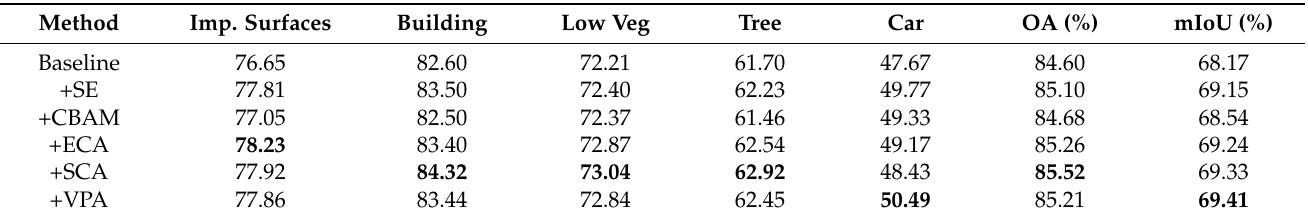
Table 5. Experimental results on the ISPRS Vaihingen dataset. The table shows IoU(%) for each class. The bold indicates the best